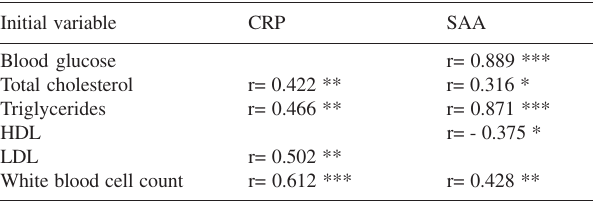
Table 1 - Correlations of C-reative protein and